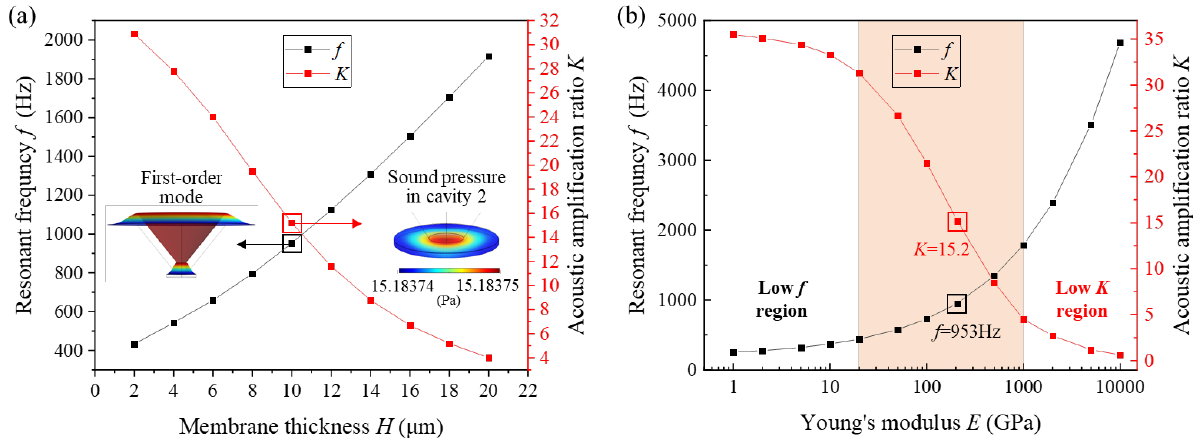
Figure 4. Acoustic simulation on ( a ) the effect of diaphragm thickness H on K and f and ( b ) the effect of Young’s modulus E of the diaphragm on K and f .